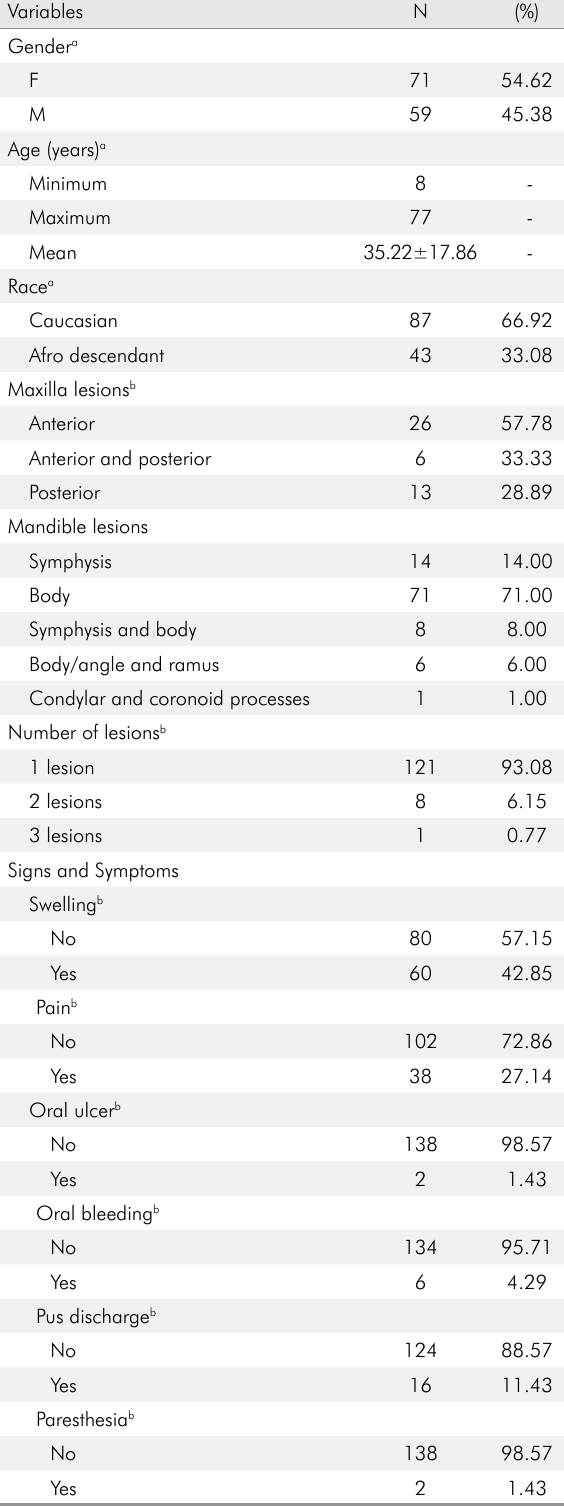
Table 1. General characteristics of 130 patients who had 140 jaw bone